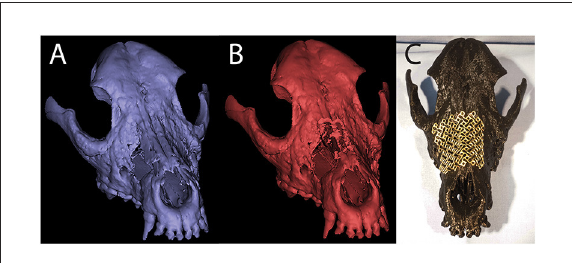
FIGURE9 Pre- (A) and post- (B) virtual osteotomy 3D computer models for case 1. The post-virtual osteotomy model was printed and used for titanium mesh contouring, which can be seen in the photograph of the 3D printed skull (C) .